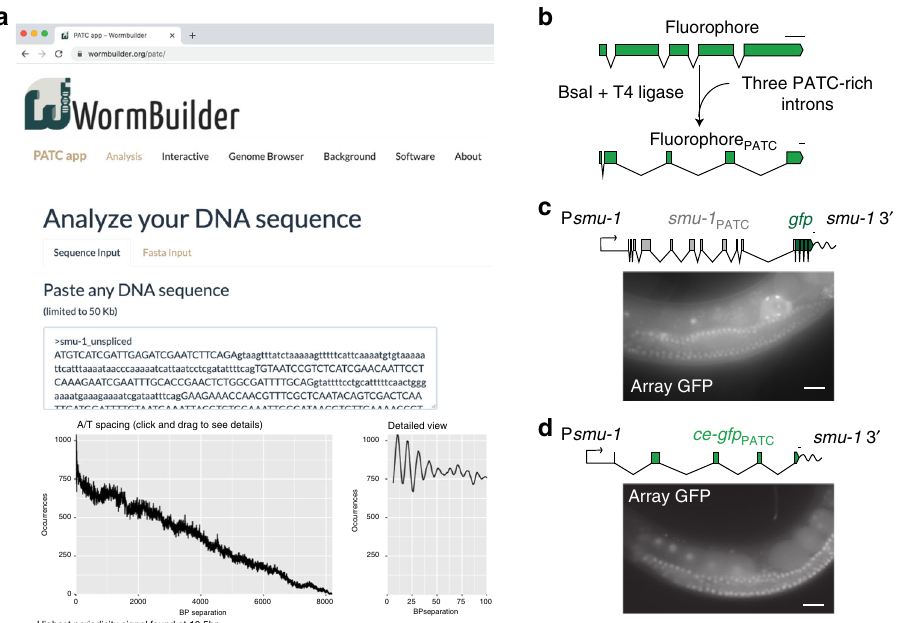
Fig. 1 A set of tools to analyze and engineer transgenes with periodic A n /T n clusters (PATCs). a Screenshot of the graphical user interface from www. wormbuilder.org/PATC/. PATC values are calculated using the PATC algorithm described by Fire et al. 26 and a modi fi ed version ( “ balanced ” ) described in Frøkjær-Jensen et al. 29 . The interactive and genome browser tabs allow visual inspection of pre-calculated genome-wide PATC values. b Synthetic introns in a transgene can be exchanged for PATC-rich introns by Golden Gate-mediated exchange using the type II BsaI restriction enzyme 34 . A library of PATC- rich donor introns (see Table 1) enables the routine exchange of three PATC-rich introns in a single reaction. c GFP expression in the germline of C. elegans from a simple extrachromosomal array carrying a P smu-1 :: smu-1 :: gfp :: smu-1 3 ′ -UTR transgene. Germline expression was independently veri fi ed in three